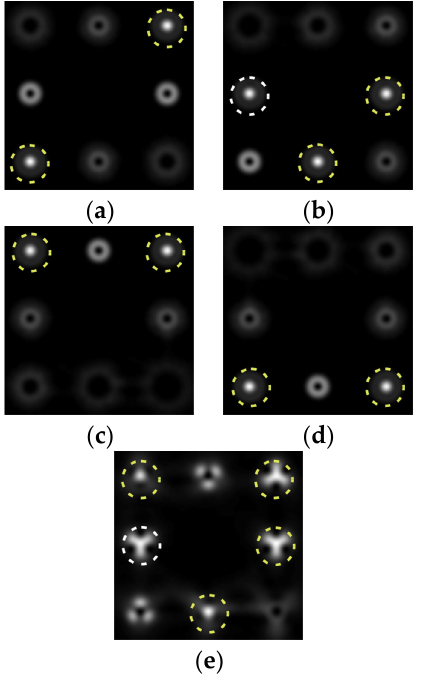
Figure 3. Action of an eight-channel DOE, matched with optical vortices in the analysis of vortex fields with cylindrical polarization of the first order ( p = 1): ( a ) m = 0, ( b ) m = − 1, ( c ) m = 2, ( d ) m = − 2, and ( e ) m = − 1, 2.